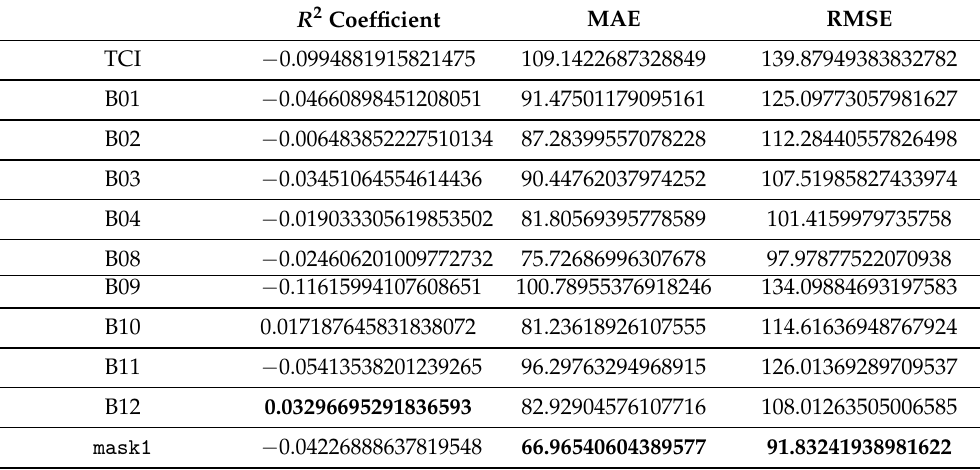
Table 5. R 2 Coefficient, MAE, and RMSE for predicting DI. Best scores are highlighted in